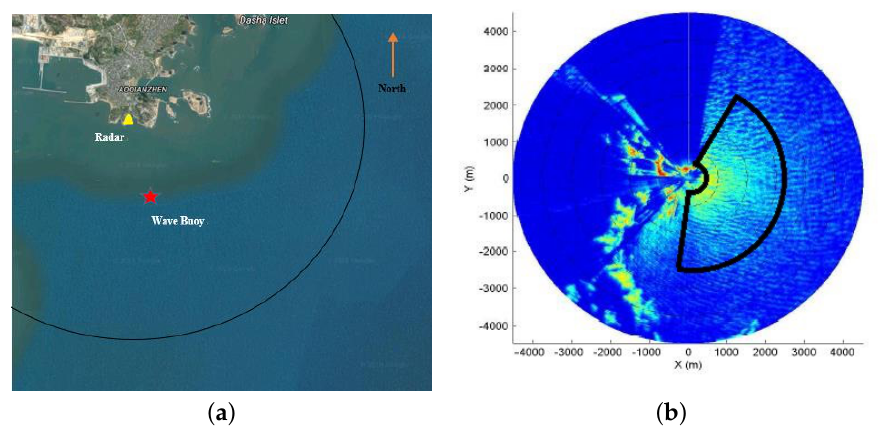
Figure 2. The experimental site and radar image. ( a ) The installed location of the marine radar and the wave buoy. The yellow triangle and the red star represent the radar position and buoy position, respectively. The black circle indicates the coverage area of the radar; ( b ) The acquired shore-based marine radar